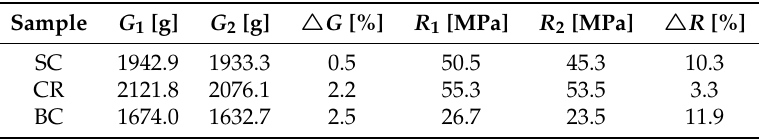
Table 4. Results of frost resistance tests.